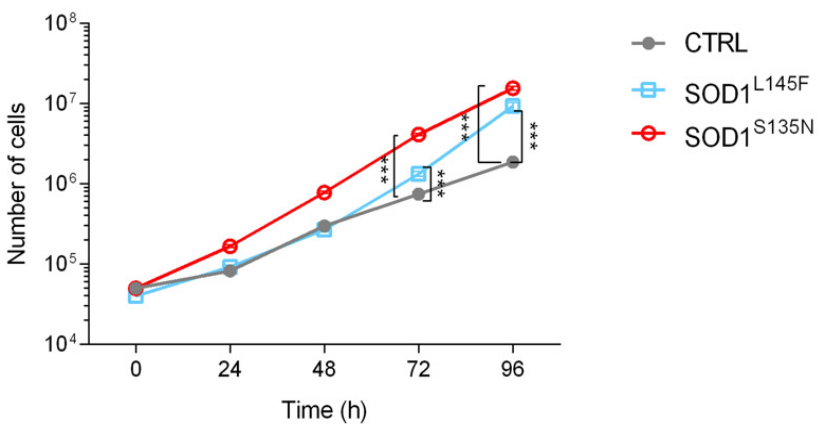
Figure 3. Growth curves of SOD1 mutants and control fibroblasts. Each point represents the mean of at least three independent experiments and results are shown as the mean ± SEM. Statistical significance: *** p < 0.001.